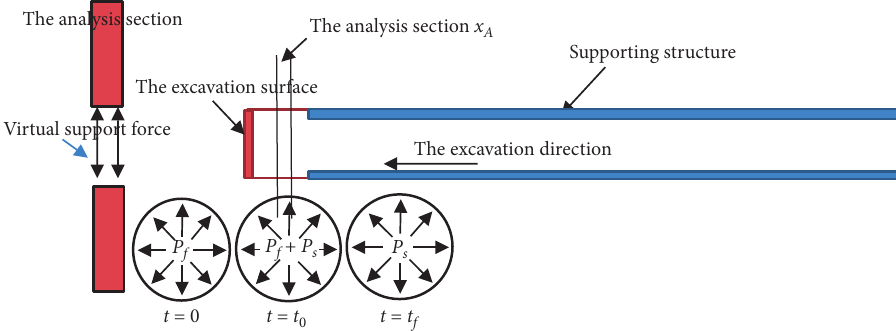
Figure 3: Diagram of virtual support